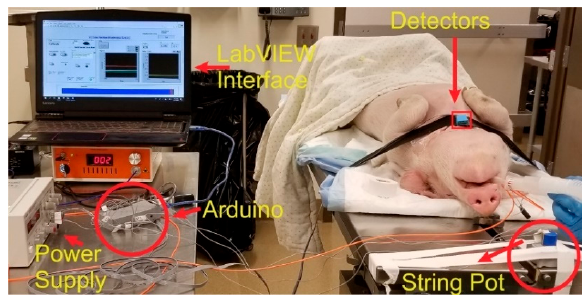
Figure 3. Photograph of the in vivo experiment with the Opt-ETT tube placed in the trachea of a pig and the detector box attached to the chest above the fiber tip.